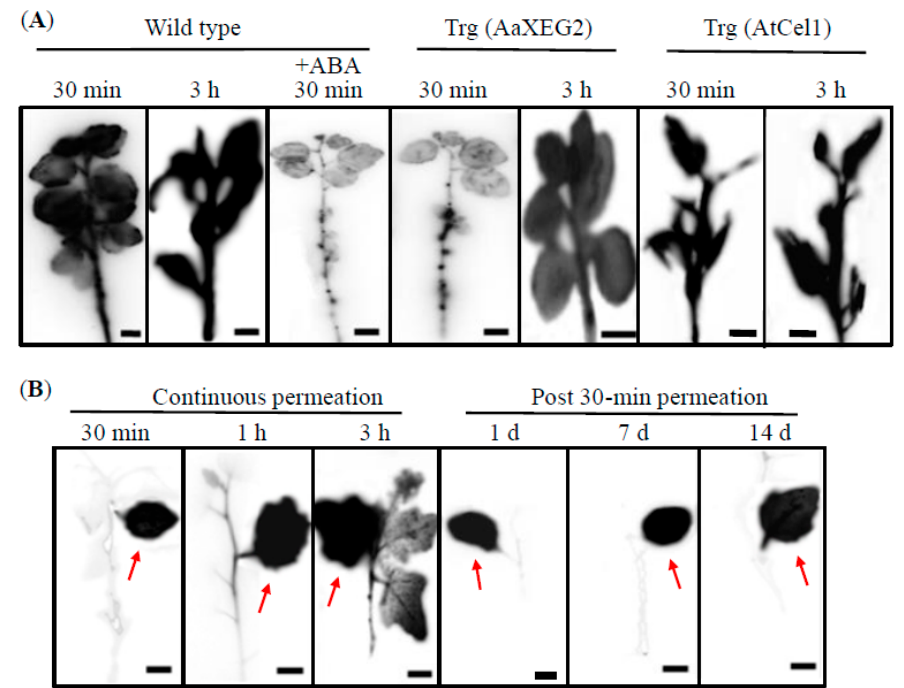
Figure 1. ( A ) Autoradiographs of Figure 1. Incorporation of radioiodine gas into poplar seedlings. ( A ) Autoradiographs of a [ 125 I]I labeled wild-type poplar seedling at 30 min and 3 h; the third seedling was sprayed with 10 μ M abscisic acid (ABA) before being treated with radioiodine gas for 30 min. Autoradiographs show